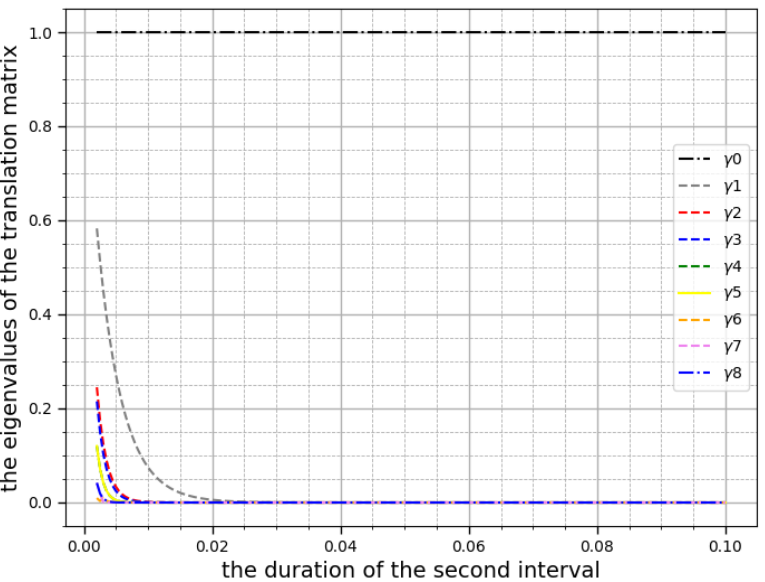
Figure 6. Dependencies of modules of eigenvalues of the probability translation matrix ( t = 0 ÷